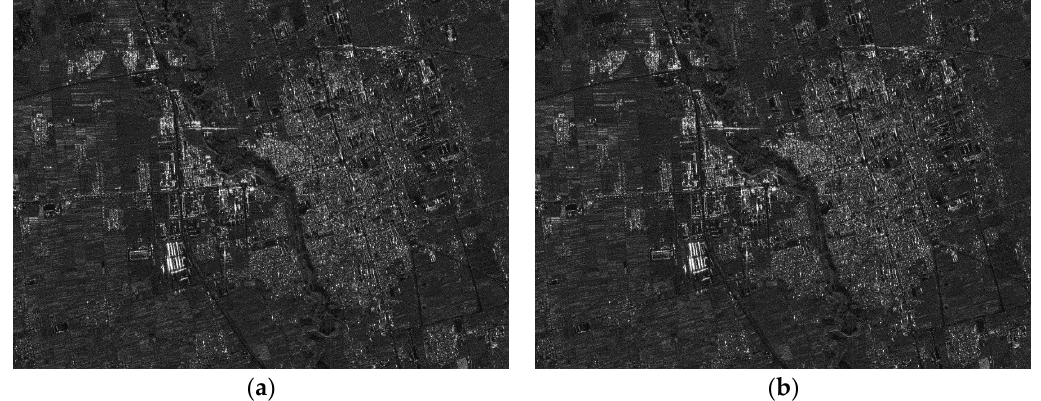
Figure 14. Results of area C (from top to bottom is range, and from left to right is azimuth): ( a ) standard full-aperture CSA; ( b ) proposed algorithm.